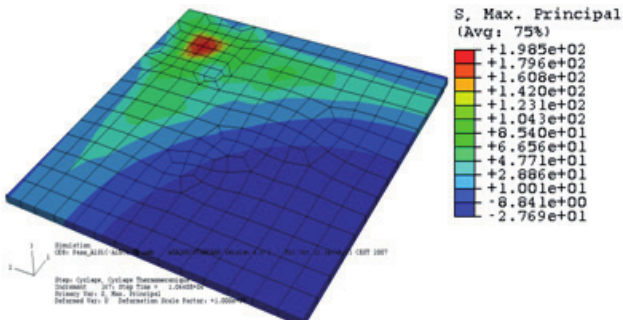
Fig. 19. ISED distribution in bumps solder after thermal cy- cling (mJ/mm 3 ).